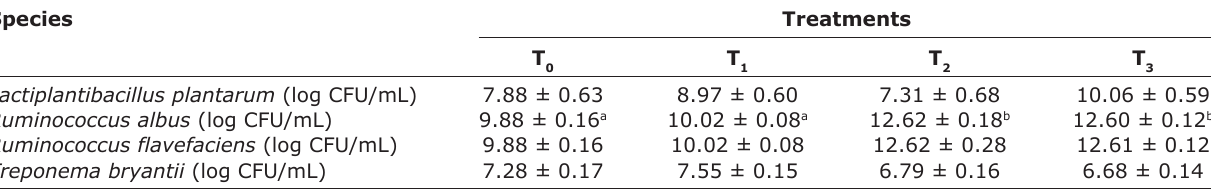
Table-4: Targeted bacterial population from in vitro rumen fermentation supplemented with probiotic. Species